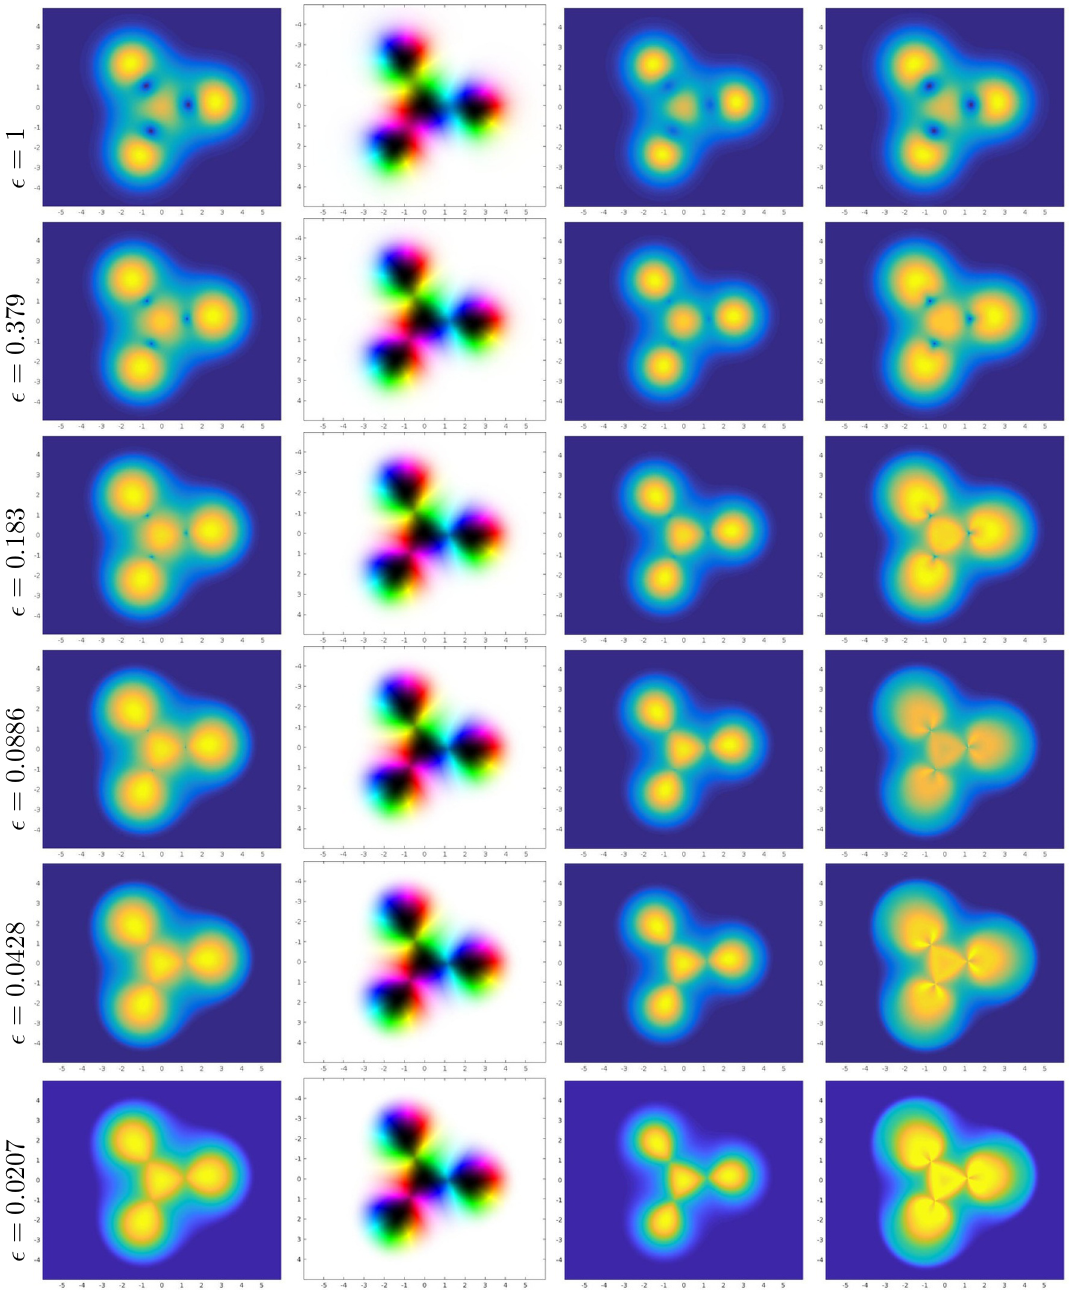
Figure 6 . The Q = 1+1+1+1 tetrahedral baby-Skyrmion solution as a function of (cid:15) . The columns display the topological charge density, the field orientation using the color scheme described in the text, the total energy and finally the kinetic term − (cid:15) L 2 . We note that the tetrahedrally symmetric baby Skyrmion exists also for large (cid:15) (i.e. (cid:15) = 1